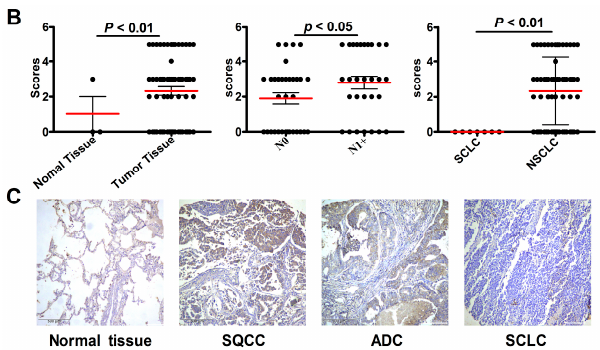
Figure 1. B-Myb expression is up-regulated in NSCLC. ( A ) Overexpression of B-Myb mRNA in lung cancer. Expression of B-Myb was determined by quantificational real-time polymerase chain reaction (qRT-PCR) with specific primers in Origene TissueScan Lung Cancer Panels (HLRT103). Grades: G1, G2, and G3. Stages: I, II, III, and IV. N0, non-lymph node metastatic; N+, lymph node metastatic. ( B ) Overexpression of B-Myb protein in lung cancer. Expression of B-Myb protein was examined by immunohistochemical analysis using lung cancer tissue microarray slides. ( C ) Representative immunohistochemical images of B-Myb expression in lung cancer (scale bar: 500 μ m). SQCC, lung squamous cell carcinoma; ADC, lung adenocarcinoma; SCLC, small cell lung cancer; NSCLC, non-small cell lung cancer. Table 1. Expression of B-Myb in lung cancer determined by immunohistochemistry. B-Myb IHC Staining (%) Pathological Variables Sample No.